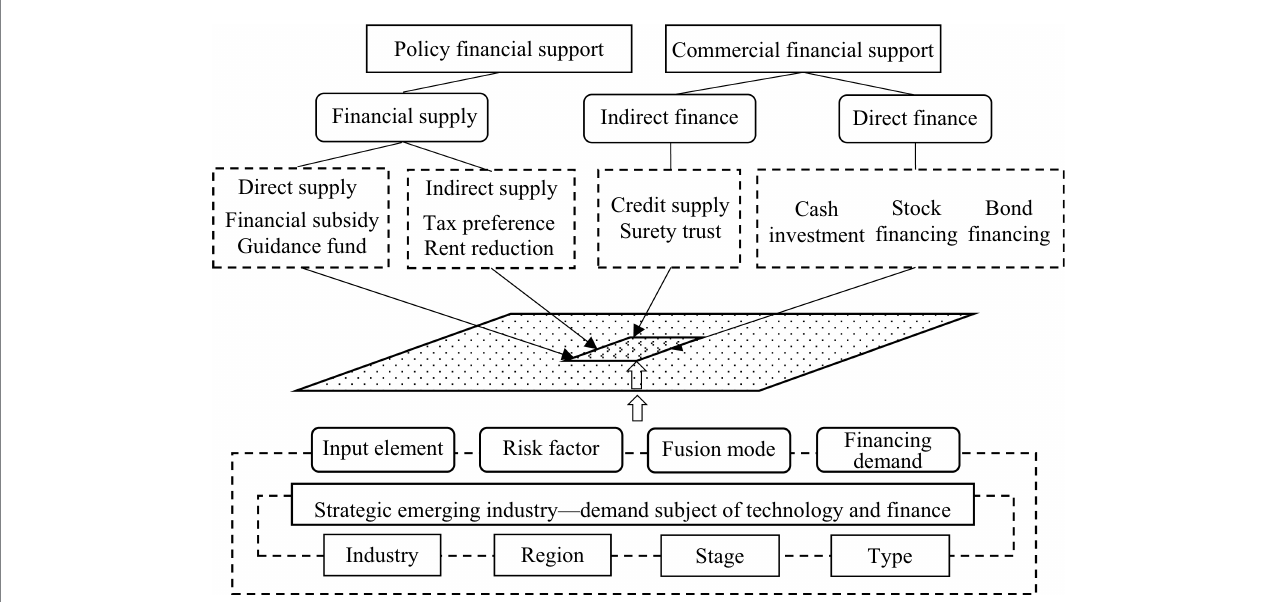
FIGURE 1 Framework model for the integration of technology and finance in strategic emerging